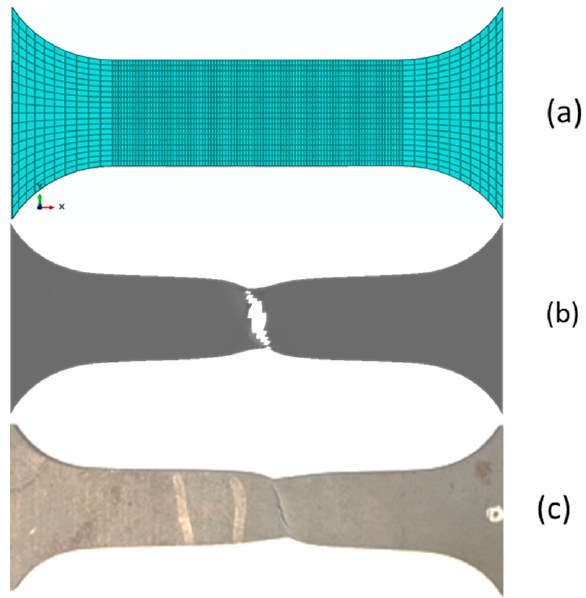
Figure 6. Specimens: ( a ) mesh with 7480 C3D8 elements, ( b ) numerical fracture in the rolling direction RD (0°) for displacement 21 mm, ( c ) experimental fracture in the RD.